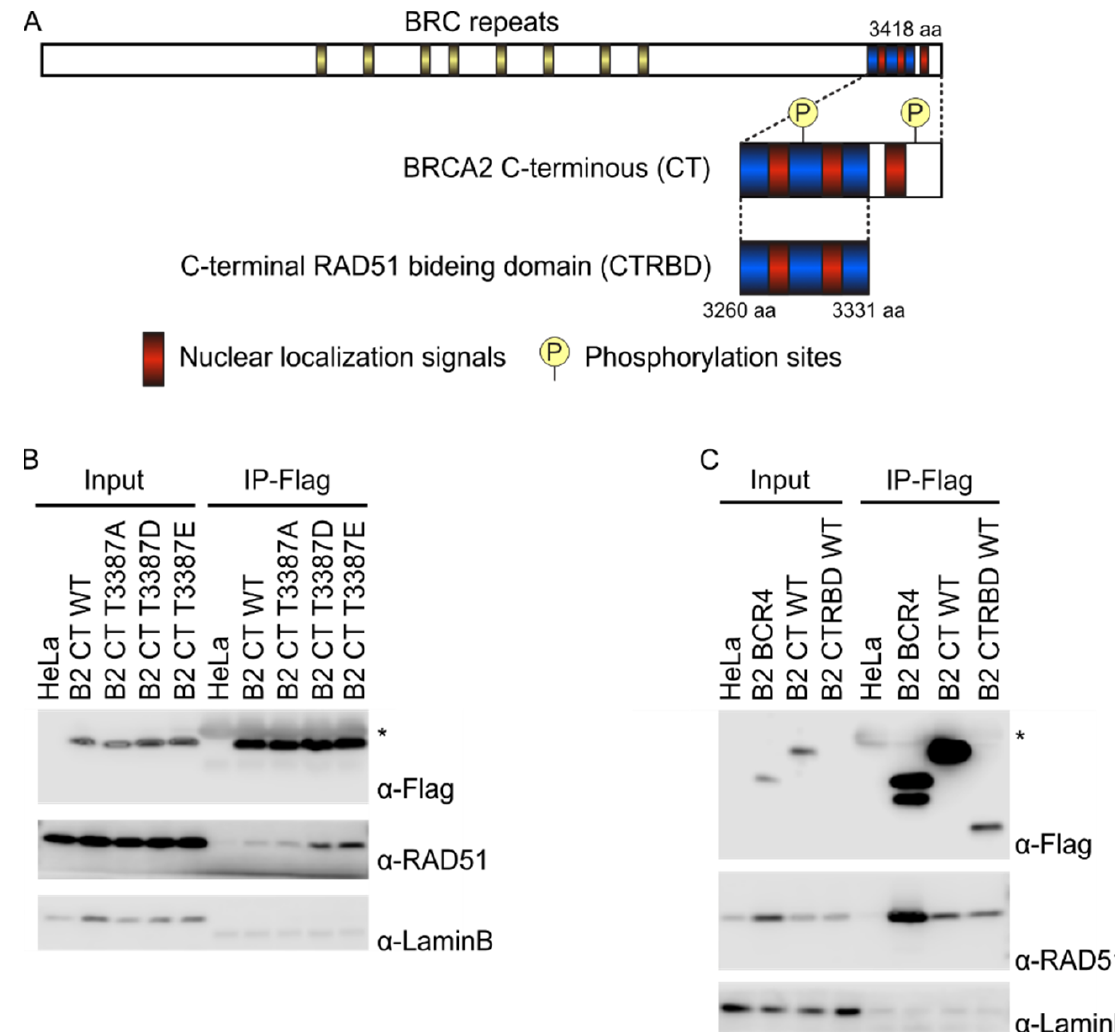
Figure 1. RAD51 interaction of the BRCA2 C-terminal RAD51-binding domain (CTRBD). ( A ) Sche- matic of the BRCA2 protein and its CTRBD. BRCA2 has two major sites to interact with RAD51: the BRC repeats and the C-terminal RAD51-binding region. Three nuclear localization signals and two phosphorylation sites (S3291 and T3387) are also indicated. ( B ) The interaction of RAD51 with the wild-type BRCA2 C-terminus (3260–3418 aa) and its phosphorylation-mimicking (T3387D and T3387E) and phosphorylation-eliminated (T3387A) mutants was assessed using coimmunoprecipi- tation. Lysates from these BRCA2 C-terminus-expressing HeLa cells were immunoprecipitated with